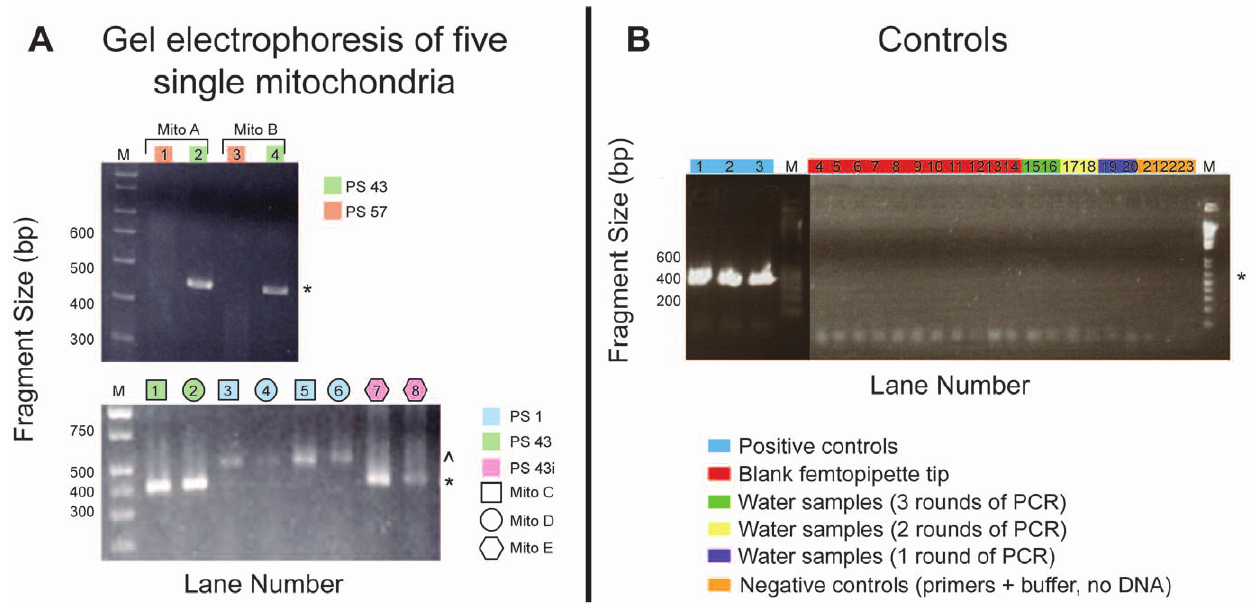
Figure 3. Agarose gel electrophoresis of amplified single mitochondrion samples A-E after three rounds of PCR. (A, top) Amplified product using PS 43 and single mitochondrion A and B (Lanes 2 and 4). Lanes 1 and 3 represent failed amplification with PS 57 and single mitochondrion samples A and B. (A, bottom) Amplified products with PS 43 (Lane 1) and PS 1 (Lanes 3 and 5) from single mitochondrion C. Amplified products with PS 43 (Lane 2) and PS 1 (Lanes 4 and 6) from single mitochondrion D. Amplified products from PS 43i for single mitochondrion E (Lanes 7 and 8). (B) Eleven Control A blank femtopipette tips inserted into the cell suspension for approximately 20 minutes after three rounds of PCR (Lanes 4–14) with PS 43. Water samples carried through 3 rounds (Lanes 15–16), 2 rounds (Lanes 17–18) and 1 round of PCR (Lanes 19–20.) Positive controls for each round of PCR (1.16 ng human DNA) with PS 43, one round PCR for each; Lanes 1, 2 and 3 for successive PCR rounds 1, 2 and 3 respectively. Negative controls for each round of PCR (no DNA) with PS 43, one round of PCR for each; Lanes 21–23 for round 1–3 respectively. M = molecular weight size markers. Primer set 43 and PS 43i showed PCR products of approximately 0.43 kb (*), while those amplified with PS 1 showed bands of about 0.47 kb ( ‘ ).